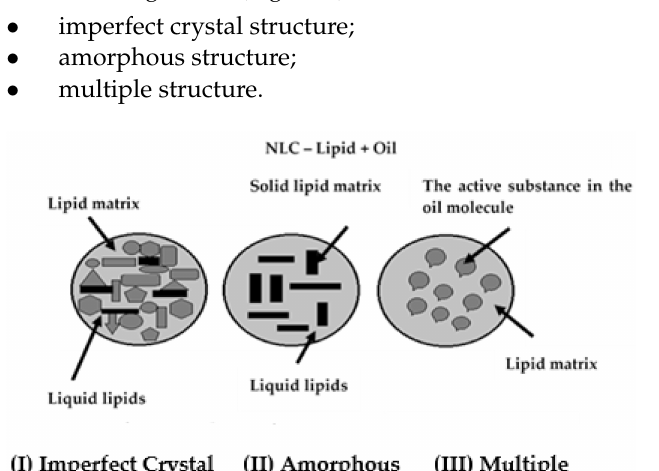
Figure 4. Structure types of nanostructured lipid carriers: ( I ) imperfect crystal, ( II ) amorphous, ( III ) multiple (modified from [2]; original paper under the terms of the Creative Commons CC BY). NLCs cannot be used to encapsulate active ingredients and drugs with a hydrophilic character. In contrast to SLNs, the NLC matrix consists not only of solid lipids but also contains liquid lipids (oils), water, and surfactants. SLN is mixed with oils in ratios ranging from 70.0:30.0 to 99.9:0.1. Higher amounts of oils can be used in the NLC multilayer structure. The entire system is stabilized with surfactants (0.5–5.0% by weight). The compounds most commonly used for NLC synthesis are